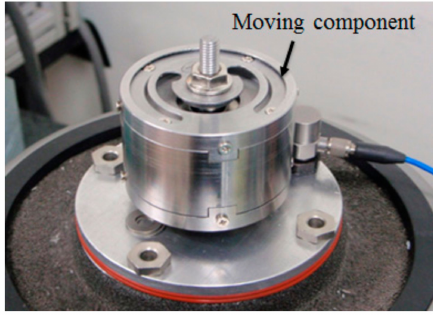
Figure 2. Vibration energy